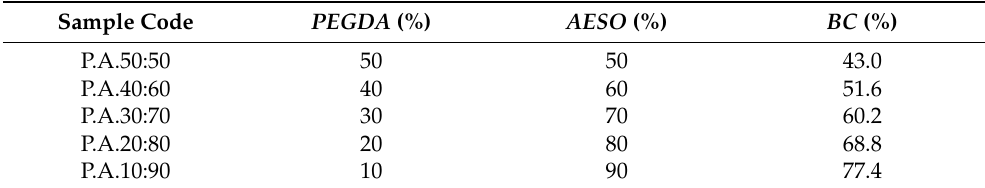
Table 1. Sample code, composition, and bio-content ( BC ) of each PEGDA / AESO